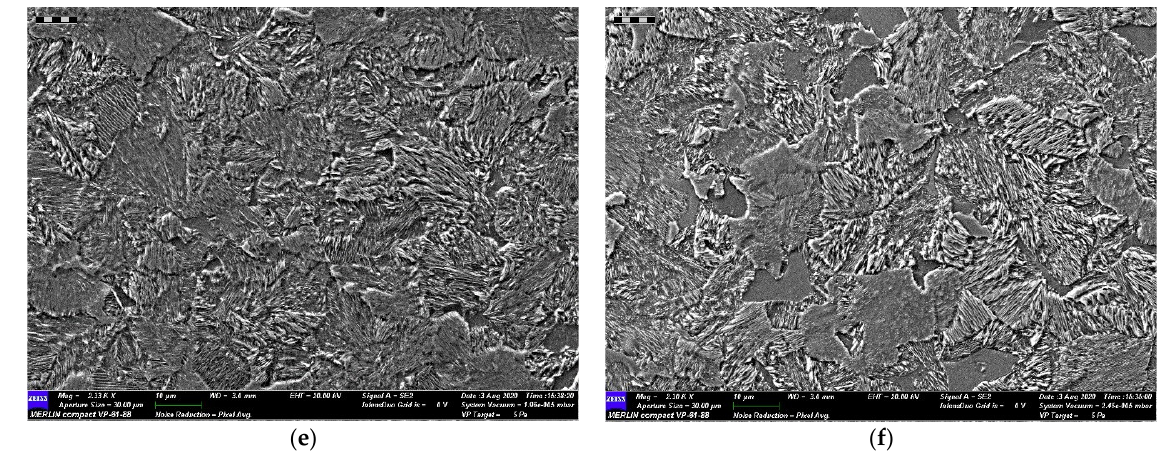
Figure 9. 54SiCr6 SEM images of the microstructure cooled at ( a ) 100 °C/s, ( b ) 30 °C/s, ( c ) 20 °C/s, ( d ) 10 °C/s, ( e ) 1 °C/s, and ( f ) 0.1 °C/s.